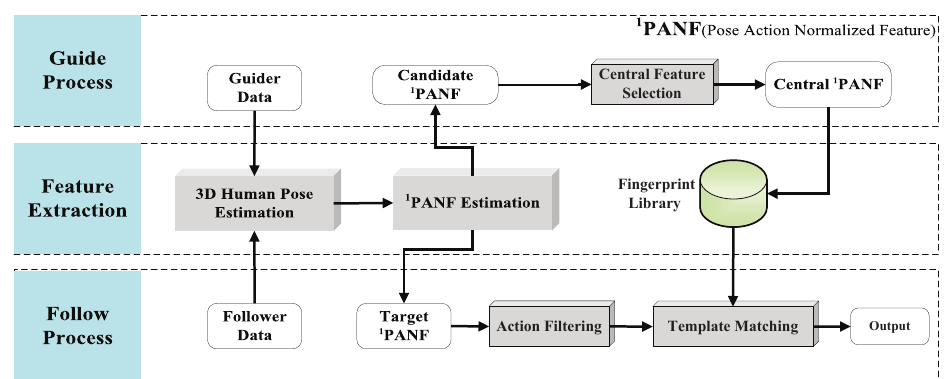
Figure 1. Framework